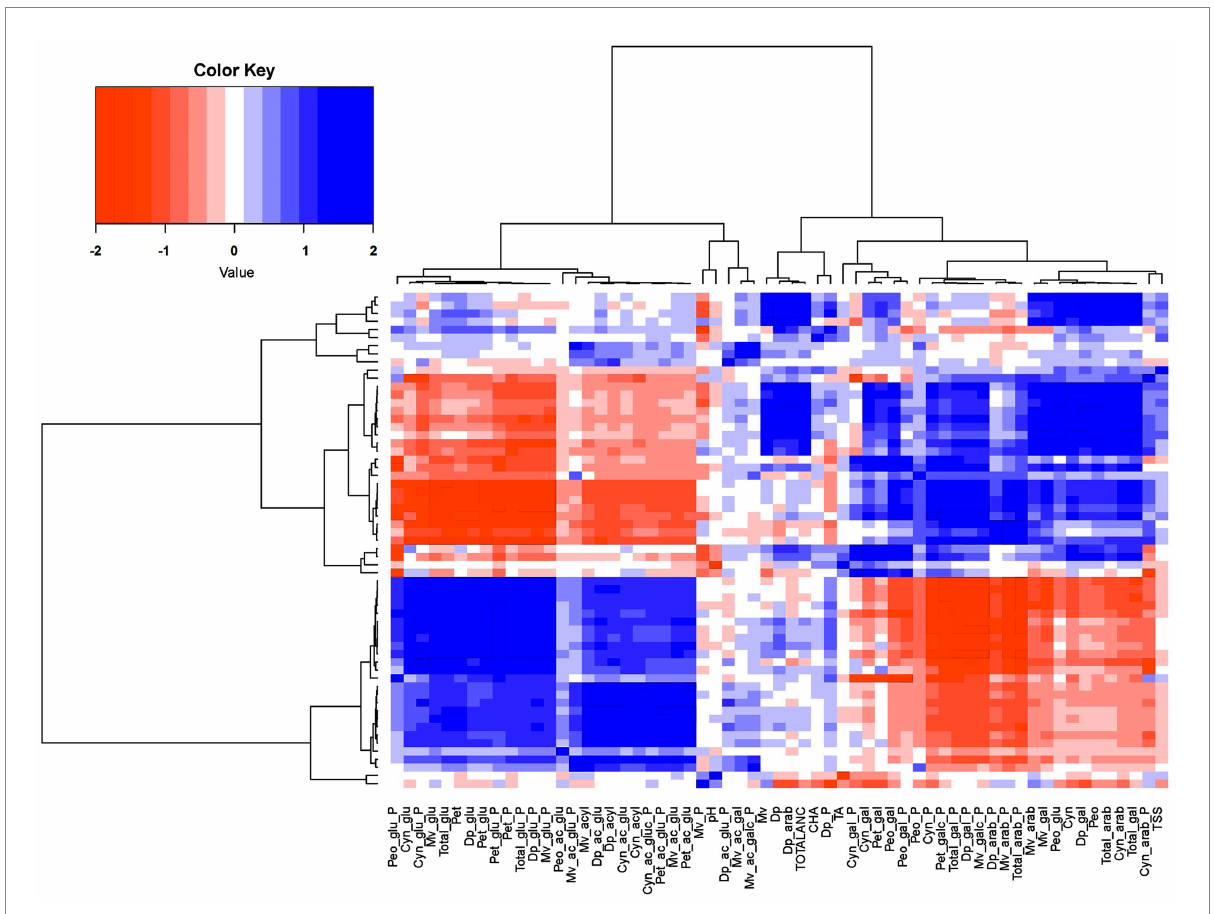
FIGURE 4 Clustering analysis. Hierarchical clustering analysis of chlorogenic acid concentration, anthocyanins concentration and relative composition (%), and fruit quality